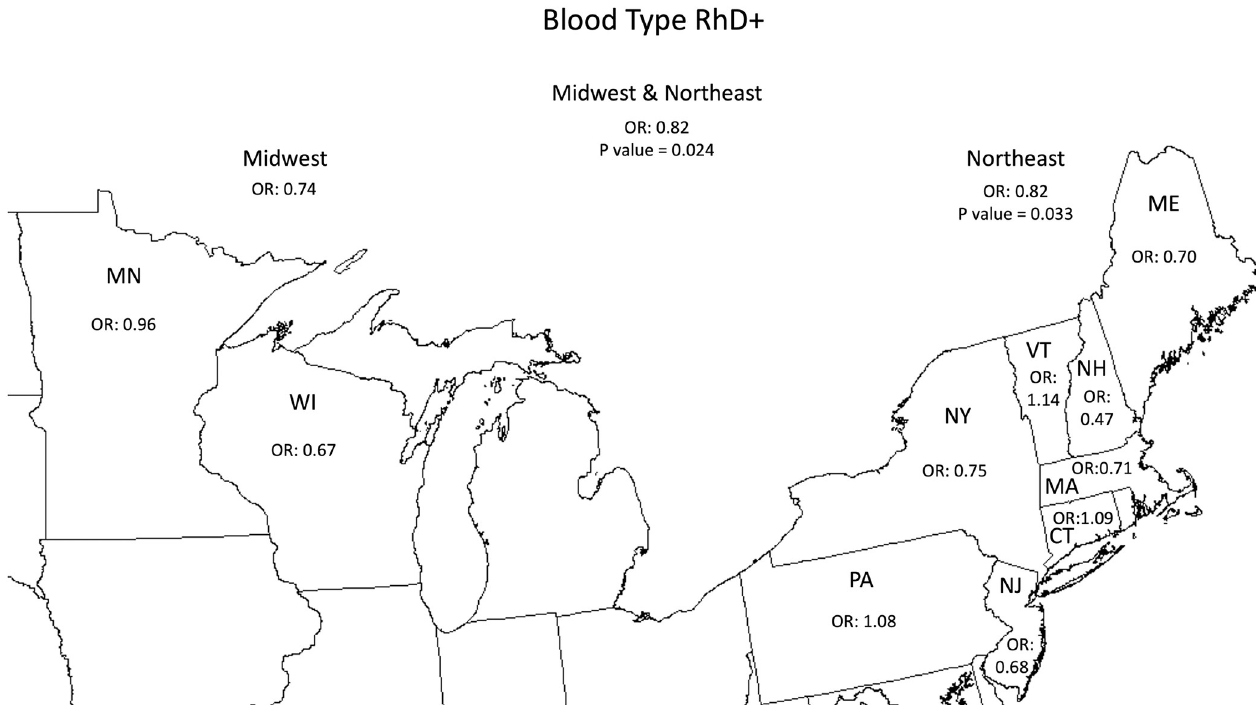
Fig 1. The association of Babesia -reactive blood donors with blood type RhD+ compared to RhD-. The associations were statistically significant (p < 0.05) in the Northeast and the combined Northeast and Midwest using a chi-square test. This map was cropped from a public domain version created by Brian Szymanski found at Wikimedia Commons website https://commons.wikimedia.org/wiki/File:Usa-state-boundaries-lower48%2B2.png.